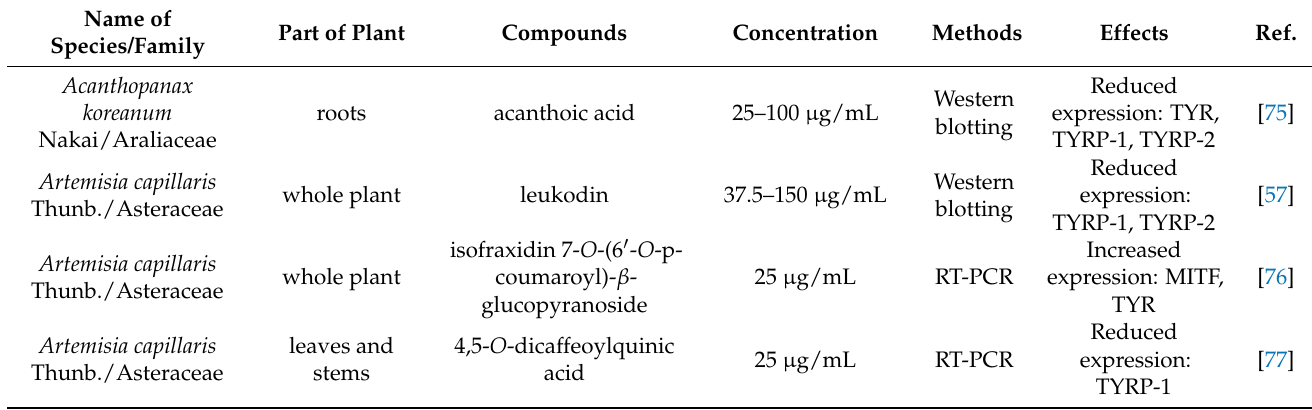
Table 3. Modulation on gene expression related to melanogenesis in B16 melanoma cells by isolated plant